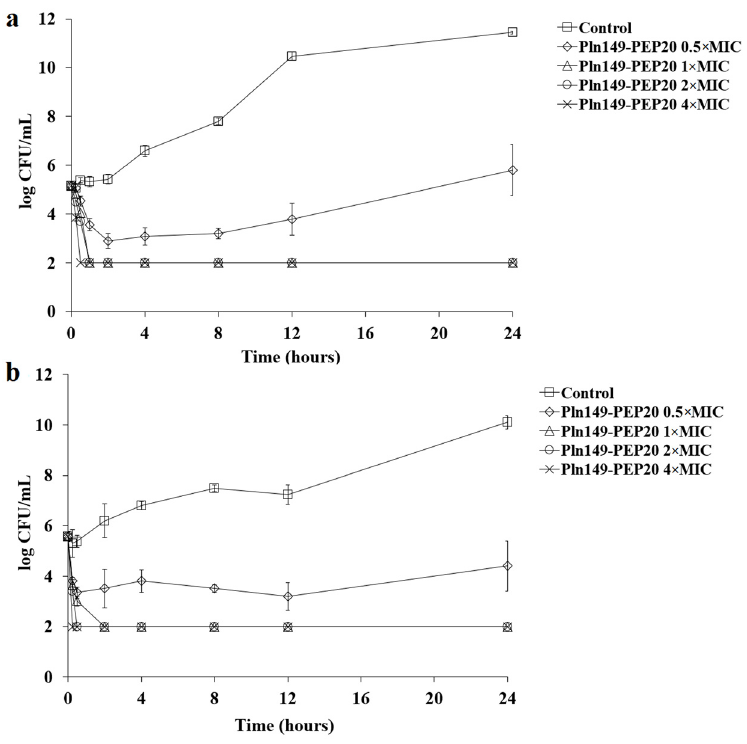
Figure 1. Pln149-PEP20 time-kill against ( a ) S. aureus ATCC 25923 (MIC = 8 mg/L) and ( b ) S. aureus SA43 (MIC = 8 mg/L).